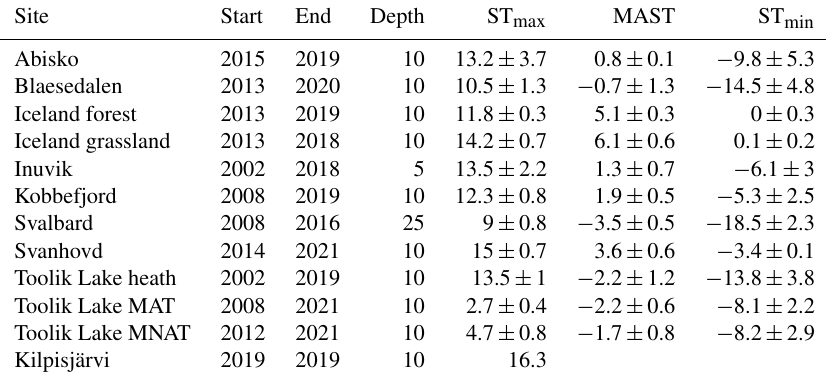
Table 1. Thermal regimes of the 12 sampling sites in ◦ C. ST max depicts the warmest day of the year, MAST is the mean annual temperature, and ST min is the coldest day of the year. ± indicates standard deviation of the mean value recorded of the temperature record from the first year (Start) till the last year (End). The fourth column (Depth) indicates the soil temperature logger depth in centimeters. Site Start End